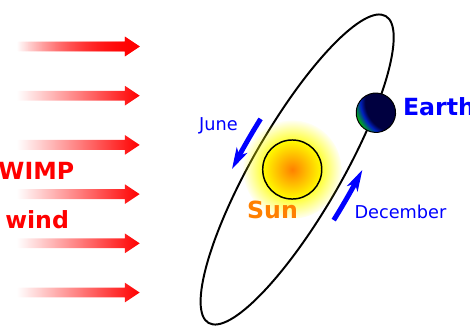
Figure 10: A schematic showing the relationship of the Earth’s orbit around the Sun to the direction of travel of the Sun through the Milky Way. The WIMP “wind” points opposite that direction of travel. Figure from Ref. [ 19 ]